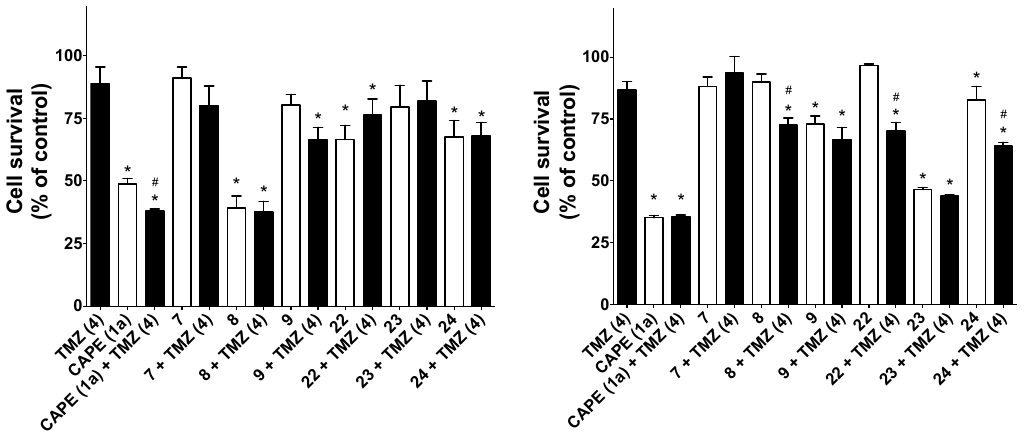
Figure 7. Hs683 ( left panel ) and LN319 ( right panel ) cell viability following treatment with CAPE ( 1a ) analogs alone or in combination with TMZ as described in the Methods. Values are the means ± SEM of three independent experiments, each performed in quadruplicate. * different from control (diluent) as determined by one way ANOVA with Dunnett’s multiple comparison test ( p < 0.05). # different from treatment with compound in absence of TMZ as determined by two-sided t -test ( p < 0.05).